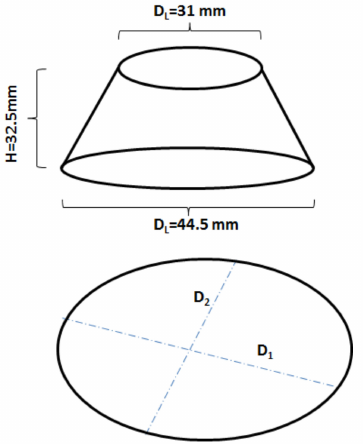
Figure 3. Schematic of the slump cone and spread flow